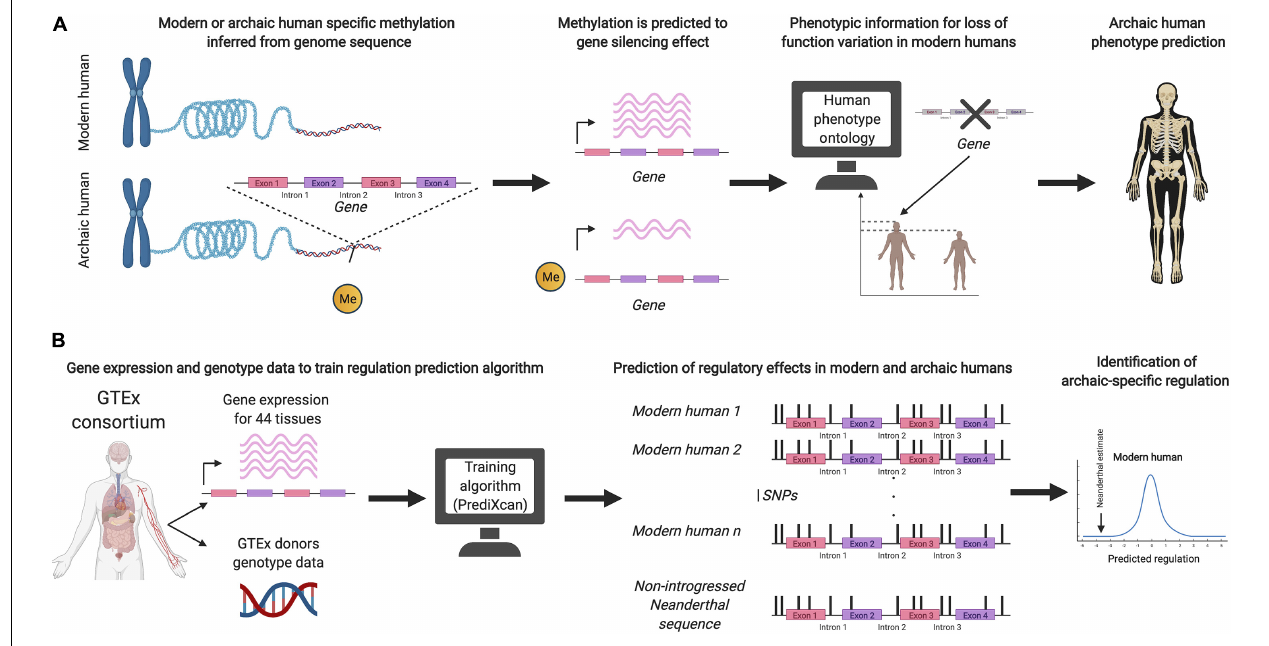
FIGURE 1 | (A) Schematic illustration of the prediction method used by Gokhman et al. (2020a) to infer archaic human phenotypes based on methylation maps. (B) Schematic illustration of the method by Colbran et al. (2019) to predict regulatory effects of non-introgressed archaic human